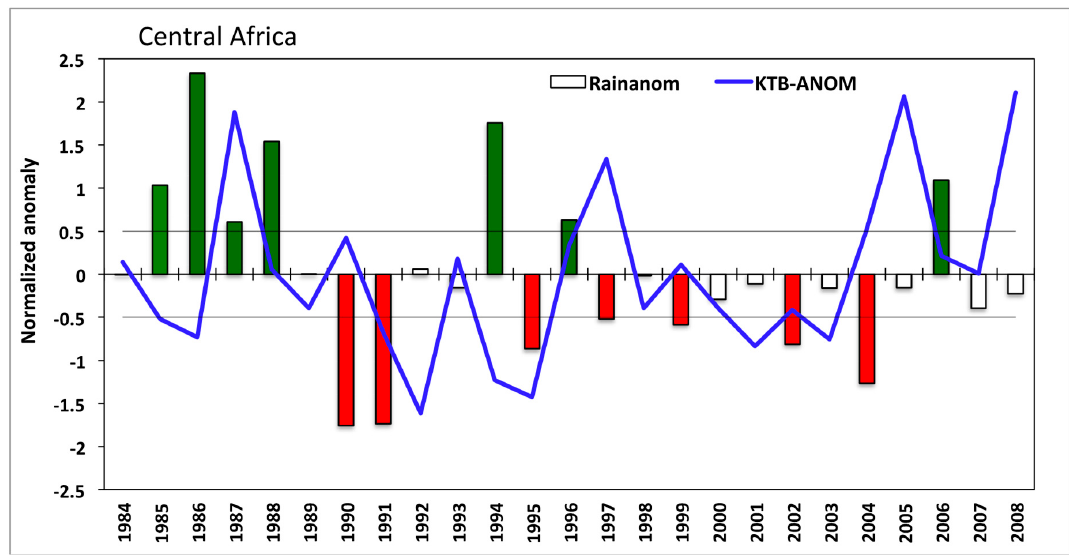
Figure 3. Year-to-year July to September normalized anomalies of rainfall (bar graph) and Kelvin filtered T B variance (solid lines) for Central Africa (7.5°–12.5° N, 10°–30° E). Wet rainfall years (>0.5 σ ) are identified by deep green and dry years ( < − 0.5 σ ) by red colors. Rainfall anomalies within ± 0.5 σ are not filled. Anomalies are departures from the mean and normalized by their respective standard deviation. The JAS rainfall for Central Africa is 5.7 mm d − 1 and σ = 0.54 mm d − 1 . The JAS KTB mean = 25.2K 2 .